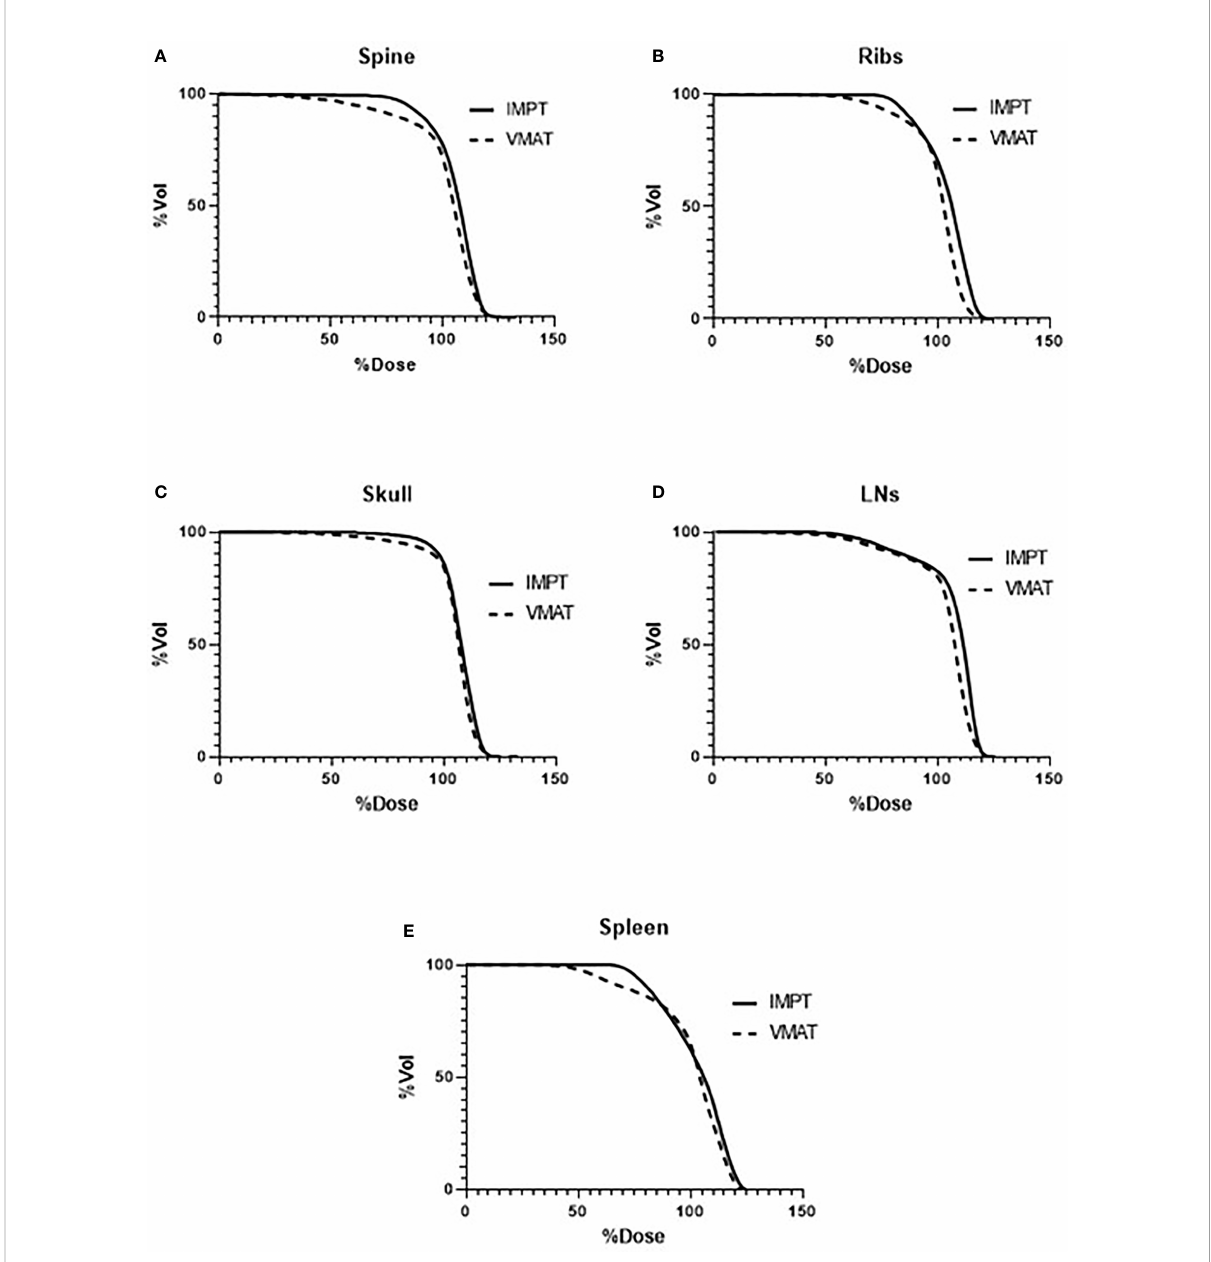
FIGURE 3 Average DVHs comparing VMAT to IMPT plans of the targets: (A) spine, (B) ribs, (C) skull, (D) lymph nodes, and (E) spleen. DVHs, dose – volume histograms; VMAT, volumetric modulated arc therapy; IMPT, intensity-modulated spot-scanning proton